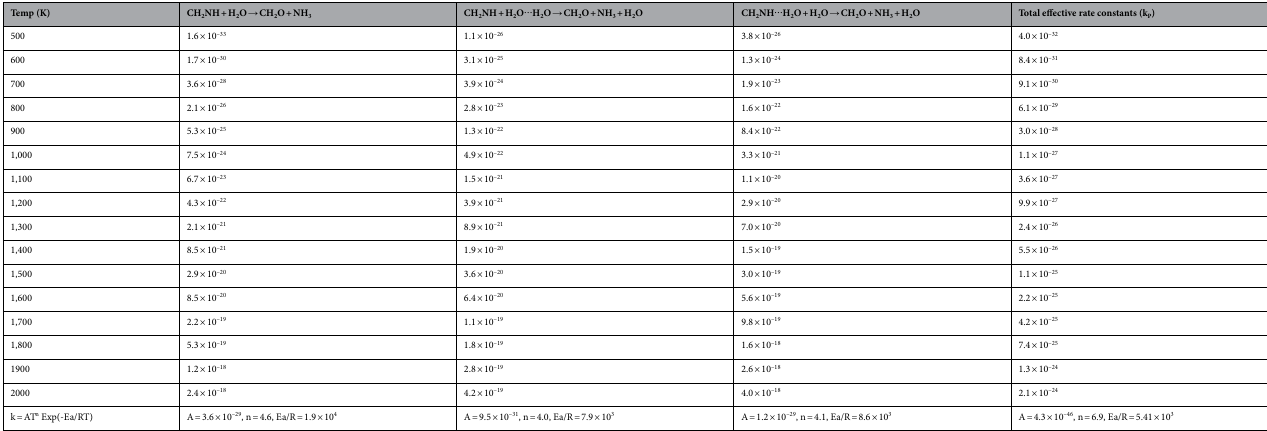
Table 2. Rate constants (cm 3 molecule −1 s −1 ) for CH 2 NH + H 2 O → CH 2 O + NH 3 and CH